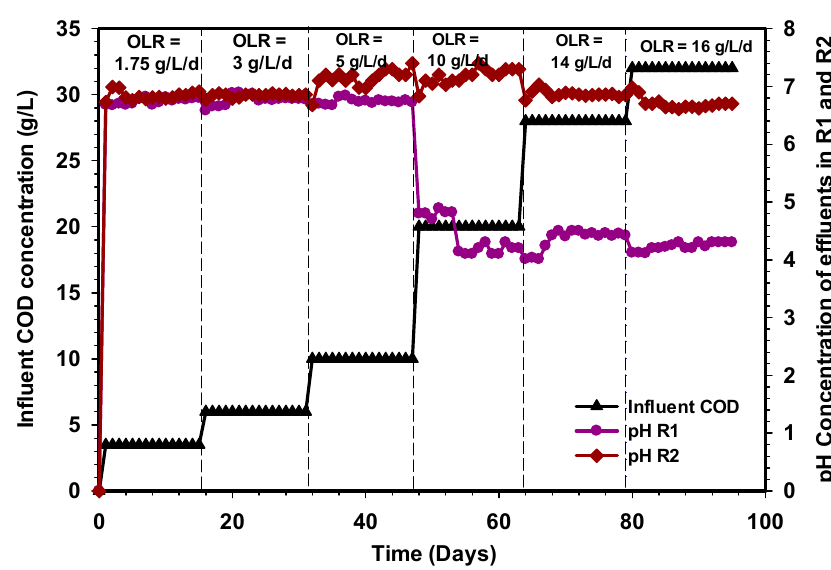
Figure 8. pH profile of the R1 and R2